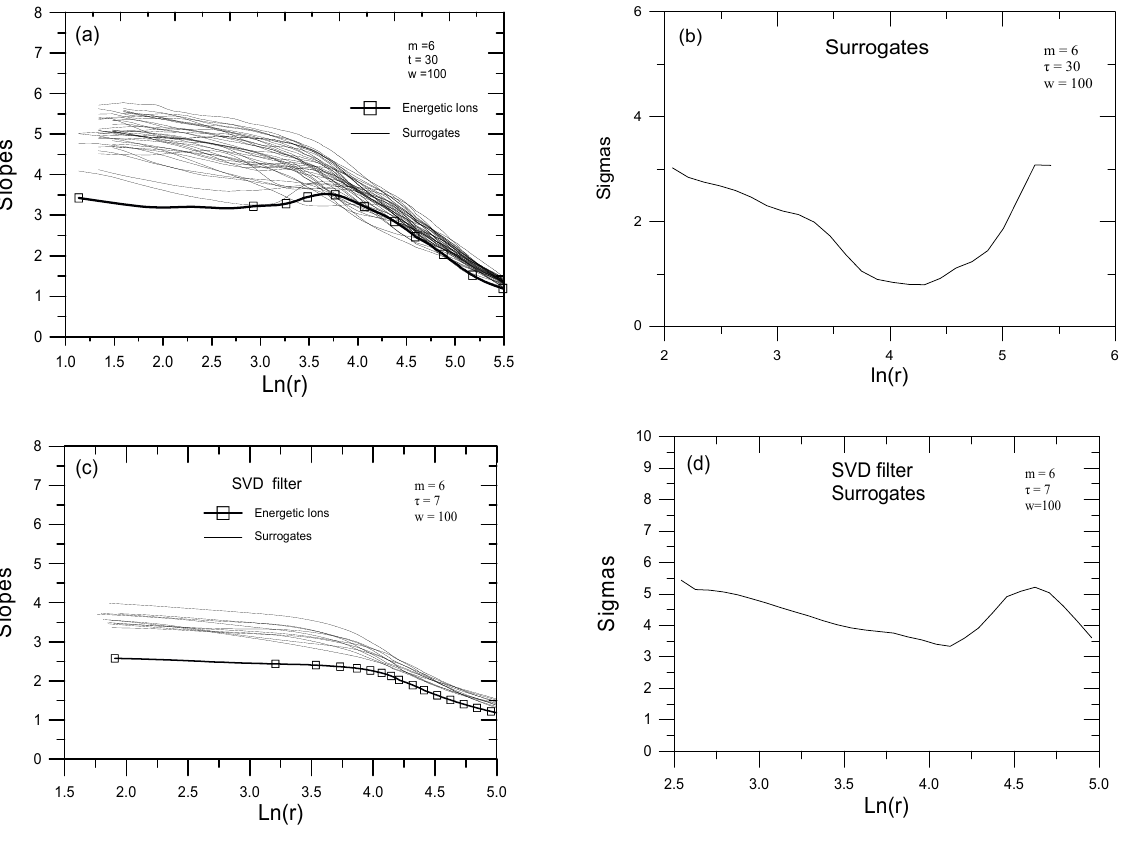
Fig. 9. (a) Slopes of the correlation integrals estimated for the original signal and its first 30 surrogate data as a function of ln (r) . (b) The Figure 9 significance of the statistics as a function of ln (r) , shown in (a). (c, d) The same as (a, b) but SVD analysis was